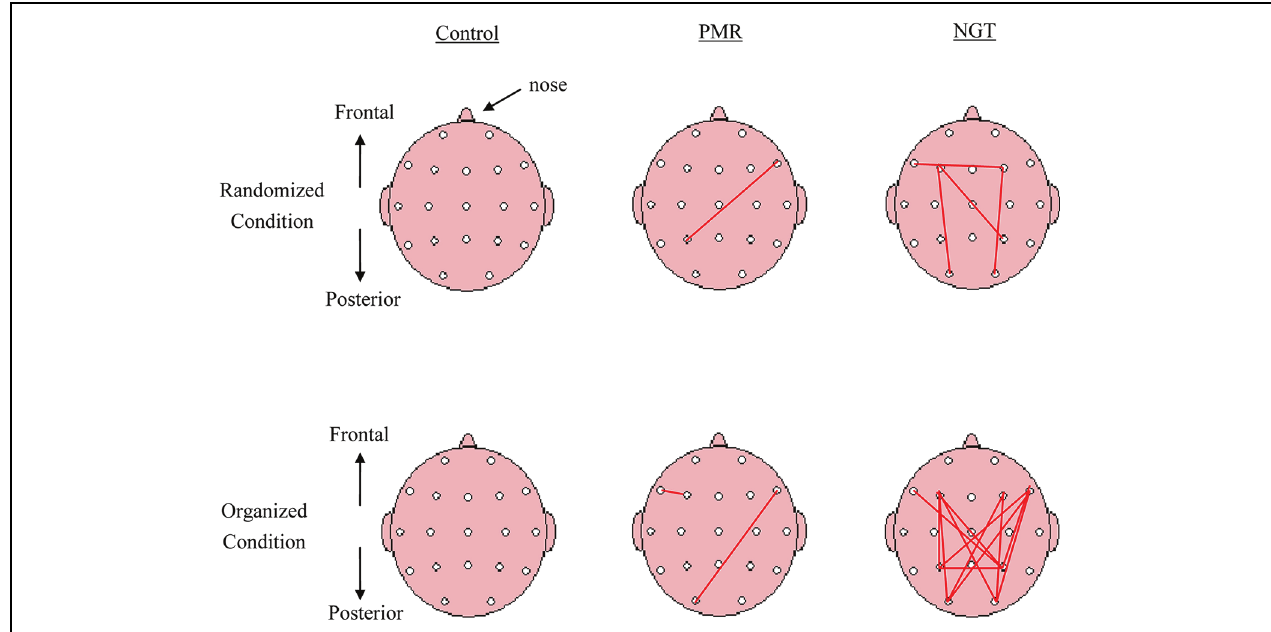
FIGURE 4 | Line topographic maps demonstrate changes in individual theta coherence pairs after training in the randomized and organized conditions across the three groups. Red lines represent coherence pairs showing a significant increase in theta coherence ( p < 0.05, paired samples t -test). Control, control group without training; PMR, progressive muscle relaxation; NGT, Nei Gong training.